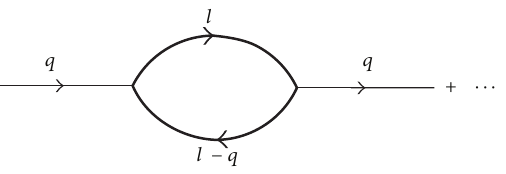
Figure 2: The first term in the so-called skeleton expansion of the two-point function. Heavy lines denote full